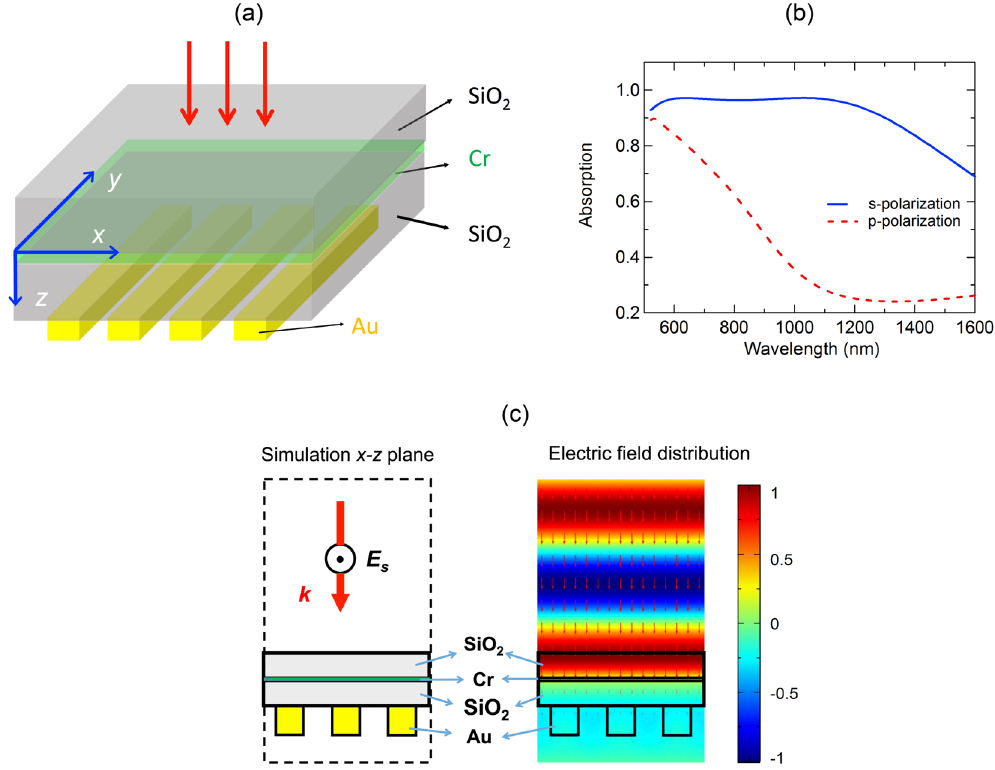
Figure 3. ( a ) Schematic of the broadband polarization sensitive perfect absorber. ( b ) Absorption for s-and p-polarization under normal incidence. ( c ) Corresponding field distribution at x–z plane for s-polarization at wavelength of 600 nm. The grating periodis 200 nm with filling factor of 0.5. The time-averaged power flow (arrows in the right figure of Fig. 3c) keeps the same intensity in the air and the top silica layer but decays rapidly below the Cr